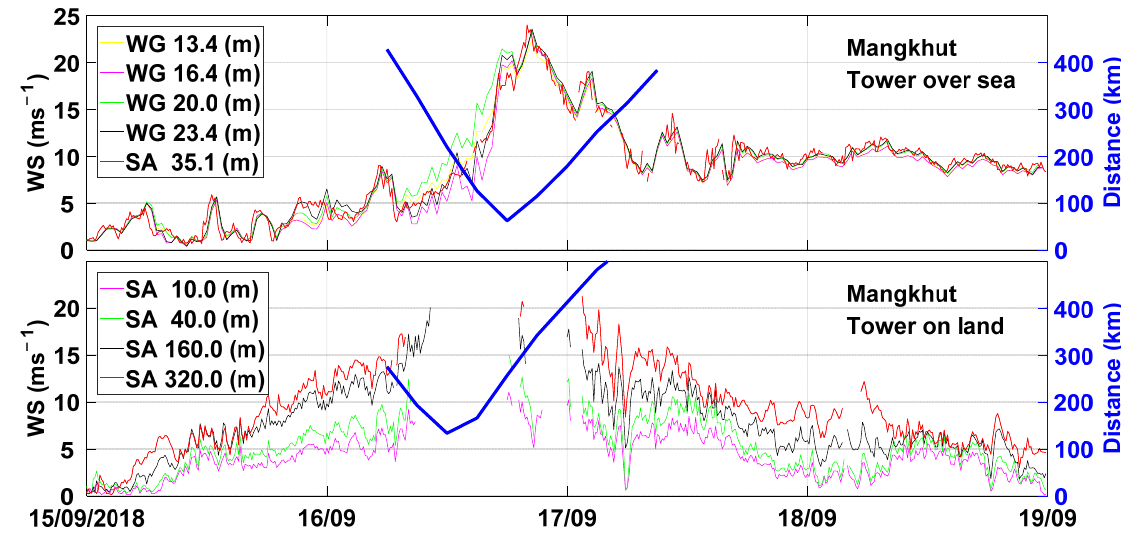
Figure 4. The same as Figure 3 except for that during Typhoon Mangkhut.